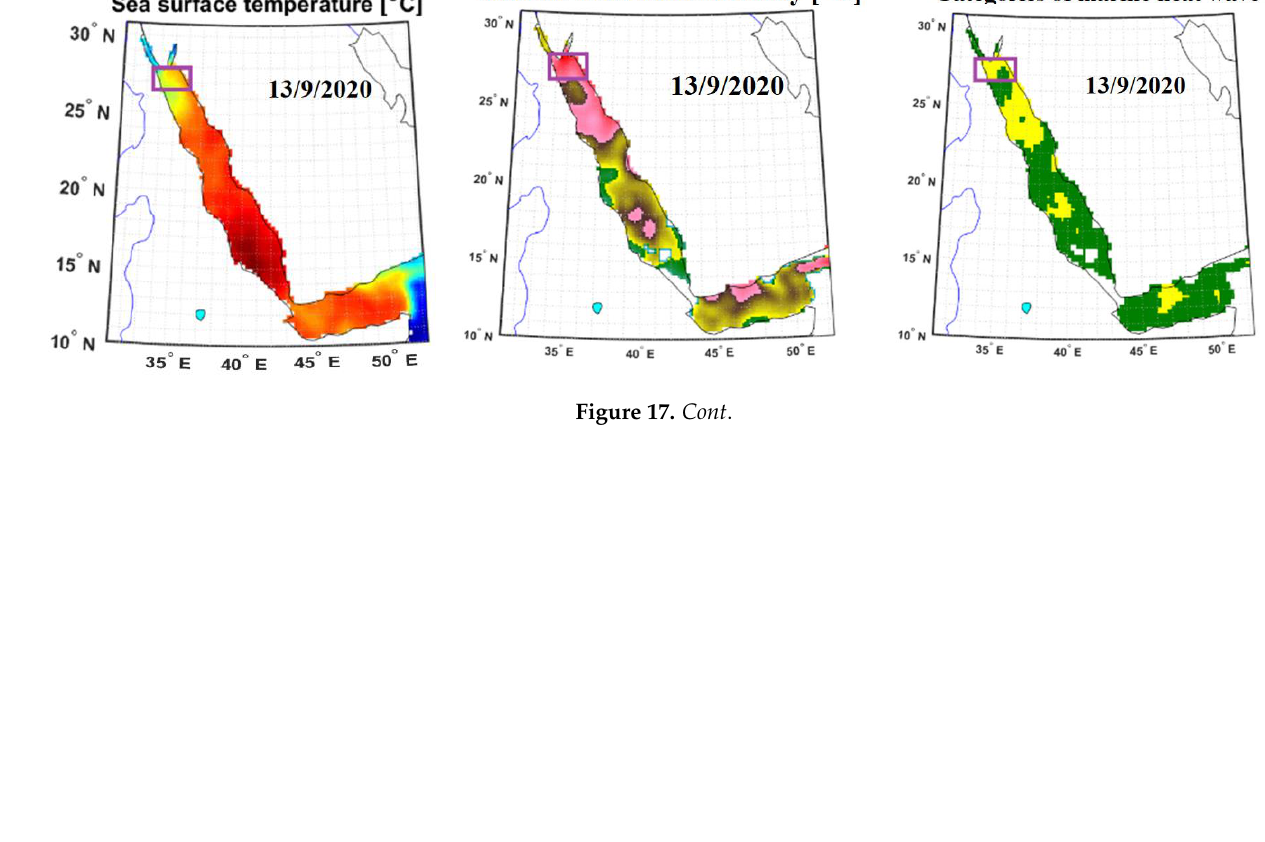
marine heat wave event ( b ) and category of that event ( c ) at the peak of the event and the time series during the event’s